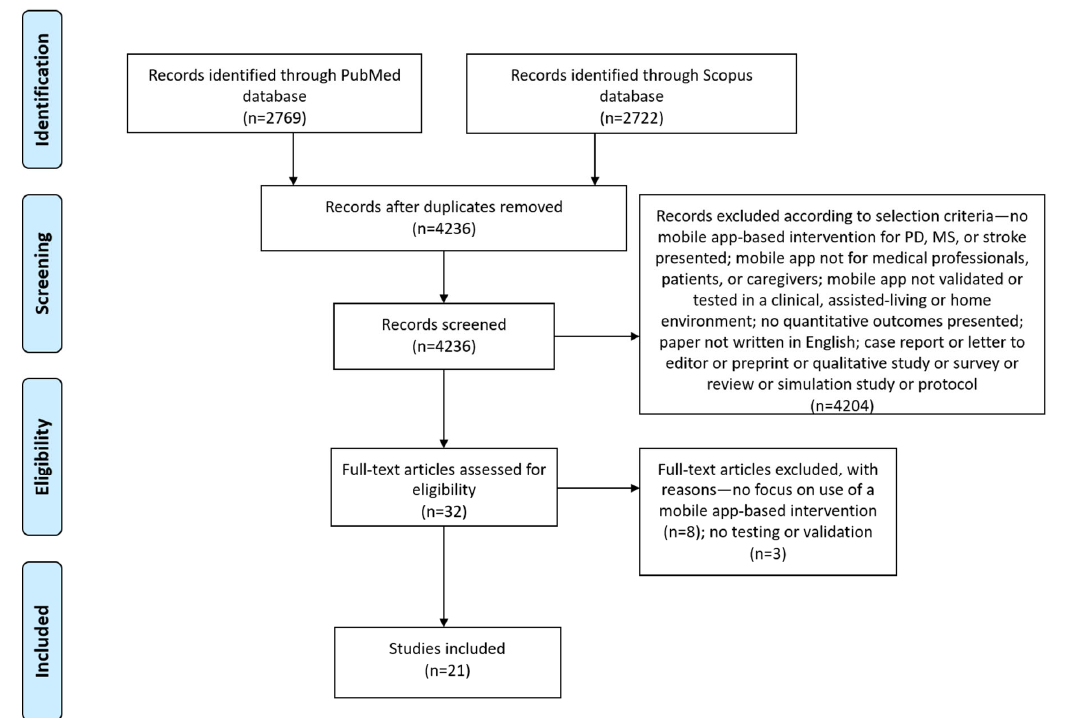
Figure 1. Prisma fl ow diagram for study inclusion. Figure 1. Prisma flow diagram for study inclusion. Table 1. Quality assessment of studies based on the EPHPP criteria (studies sorted by disease alphabetically, SB: Selection Bias, SD: Study Design, CF: Confounders, BL: Blinding, DC: Data Collection, WD: Withdrawals and Dropouts, GR: EPHPP Global Rating, W: Weak, M: Moderate, S: